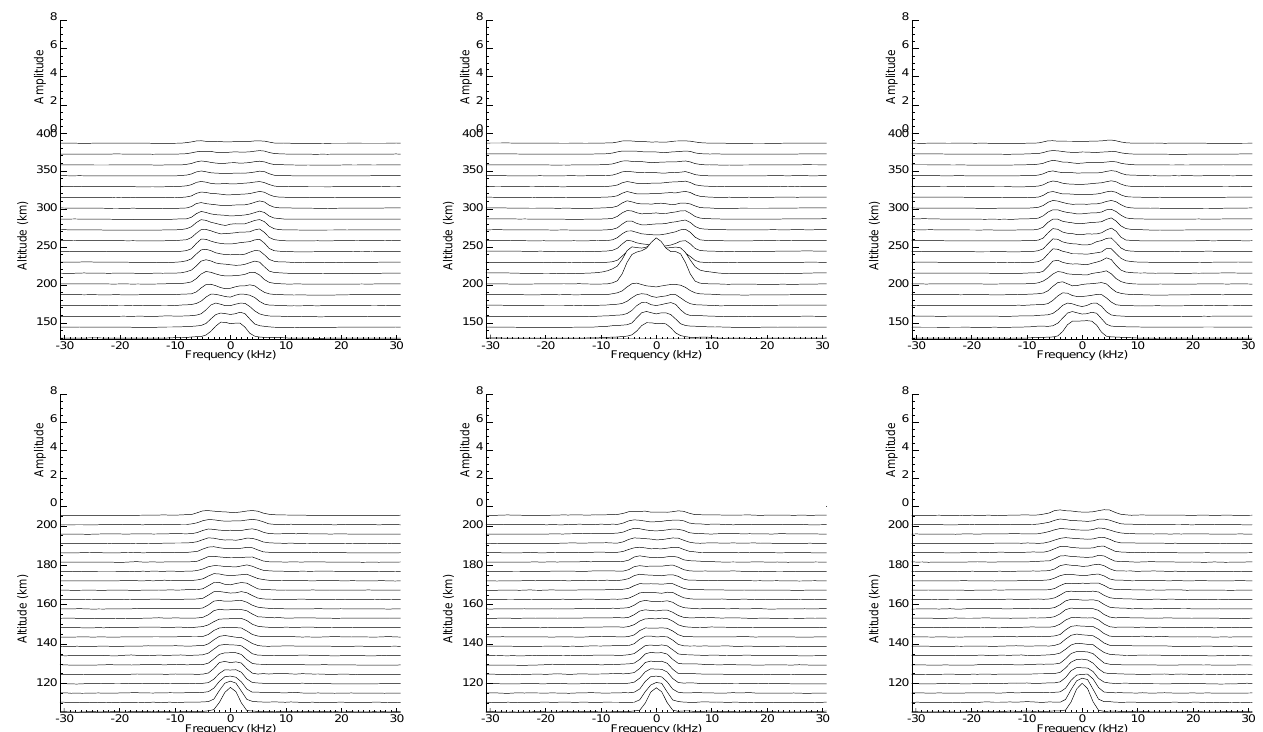
Fig 8 Fig. 8. ESR ion-line data for 12:00–12:12 UT, 27 April 2004. The upper panels correspond to the height range 129–757km with a